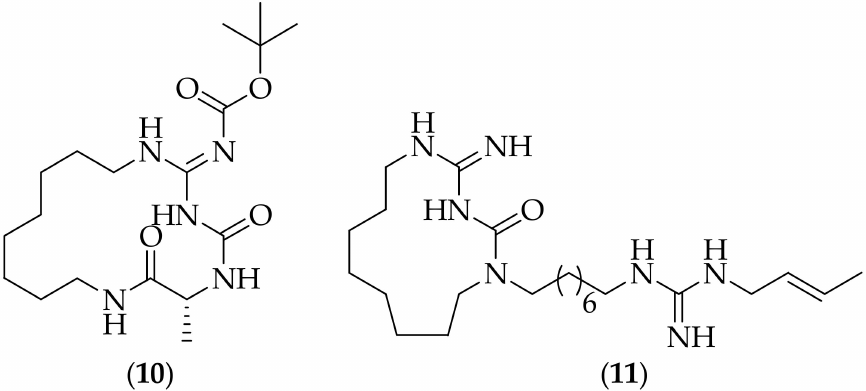
Figure 6. Cyclized derivatives ( 10 ) and ( 11 ) related to